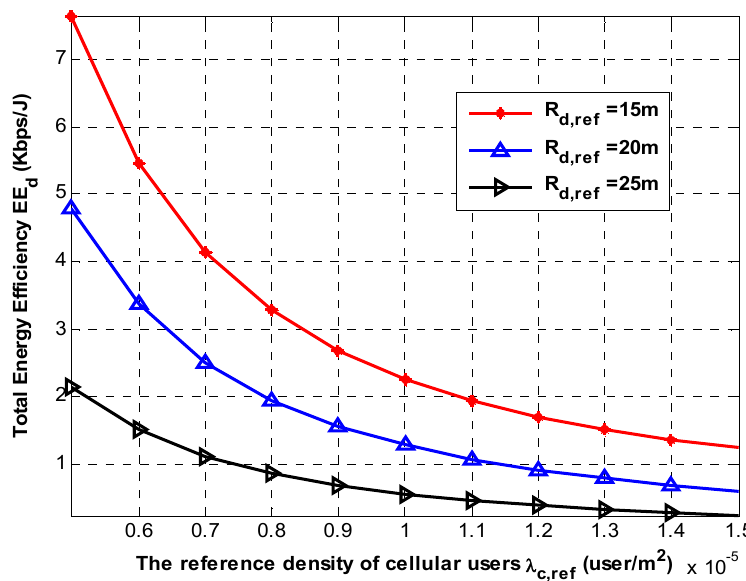
Figure 4. The energy efficiency of D2D users with the reference density of cellular users by using the derivative algorithm.